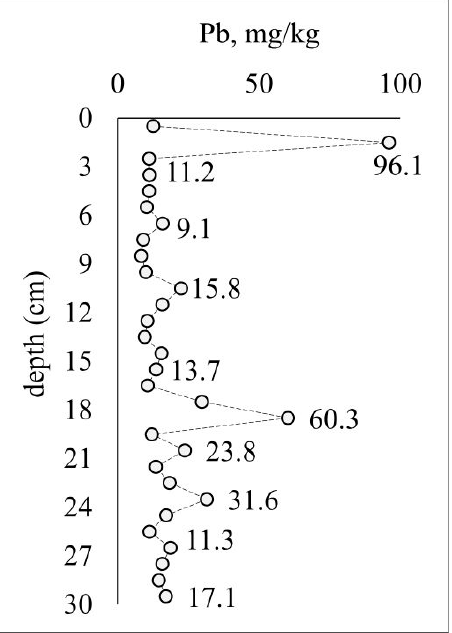
Figure 15. The vertical distribution of Pb in sediments of Lake Kenteturku (the Arctic) [88].